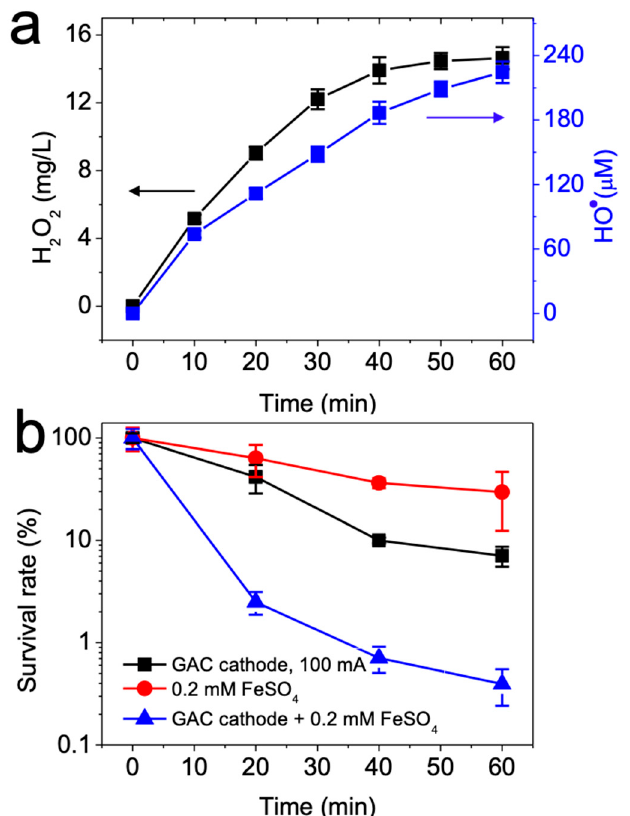
Figure 2. ( a ) GAC as the cathode to produce hydrogen peroxide and hydroxyl radical after addition of iron ions and ( b ) generated hydroxyl radical inactivated E. coli . Conditions: 3 g GAC as cathode under 100 mA current, 0.2 mM FeSO 4 , 10 8 CFU/mL (CFU, colony forming unit) E. coli , pH ini 7. 100 mA current, 0.2 mM FeSO 4 , 10 8 CFU / mL (CFU, colony forming unit) E. coli , pH ini